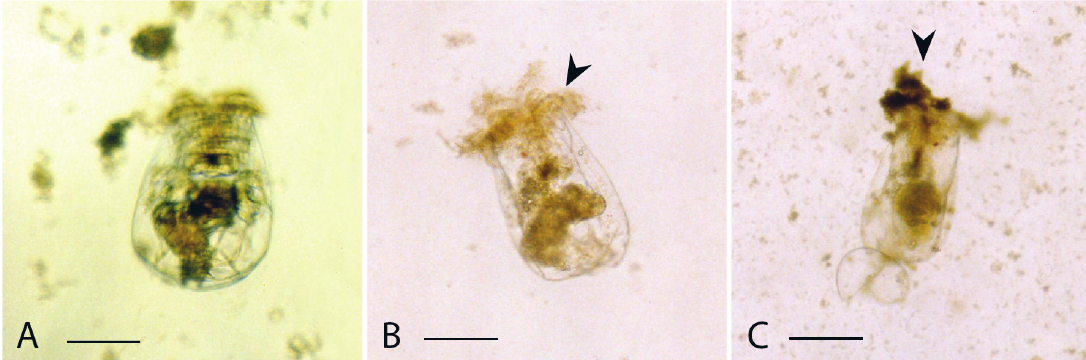
Figure 4. Light micrographs of rotifers exposed to ( A ), methanol in the control experiment for 24 h, showing a healthy individual; ( B ), lipophilic extract of Vicicitus globosus (VgTx) for c . 80 min, showing cellular materials being discharged from the dead individual (arrowhead); ( C ), lipophilic extract of Chattonella marina (CmTx) for c . 20 h, showing cellular materials being discharged from the dead individual (arrowhead). (scale bars from A to C = 100 μ